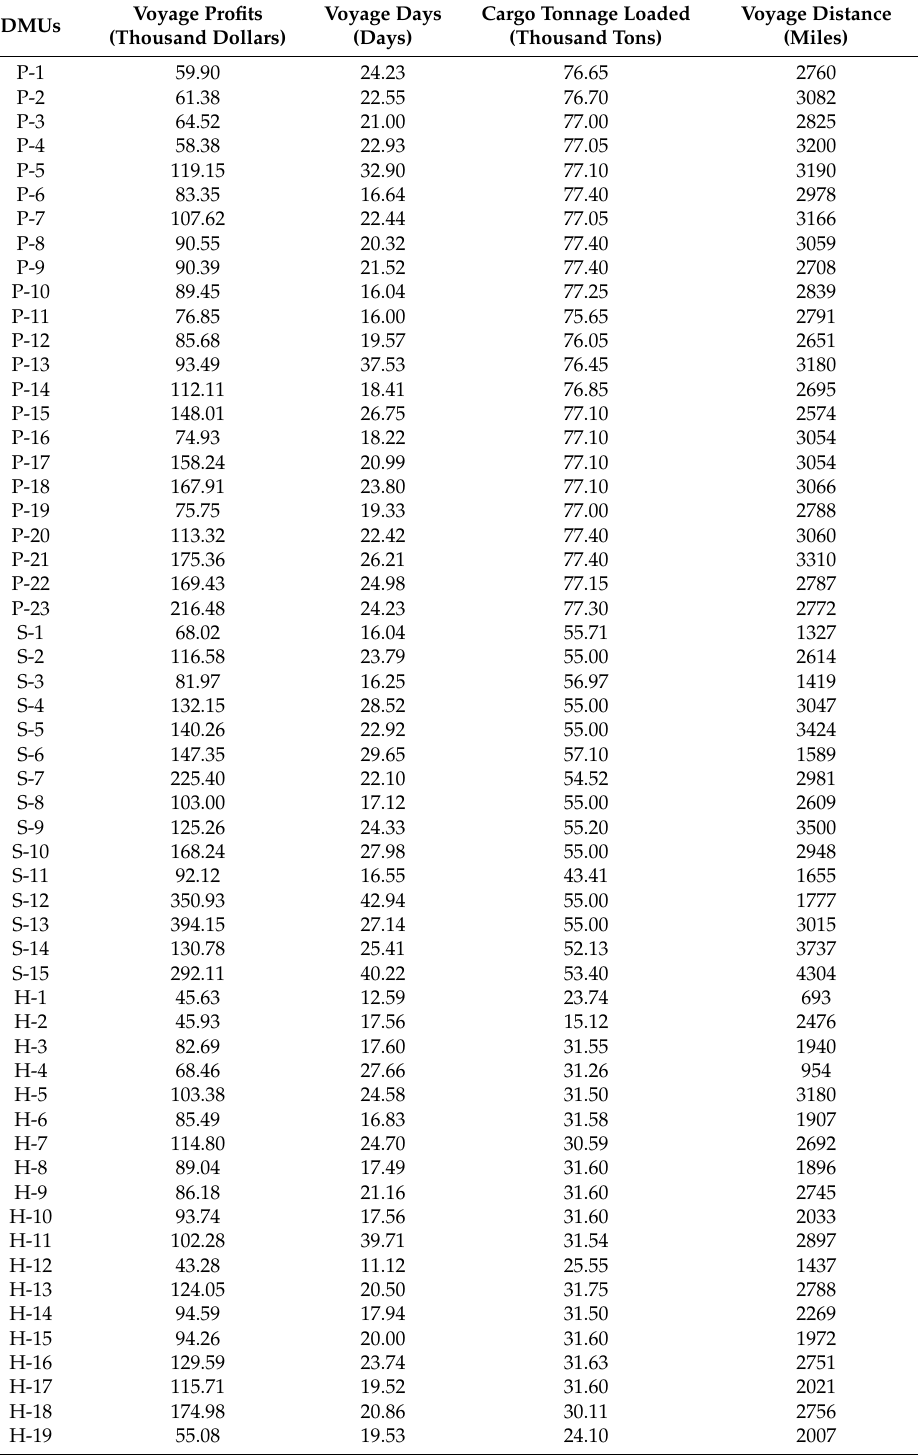
Table A1. Shipowner decision making unit (DMU) input items and output